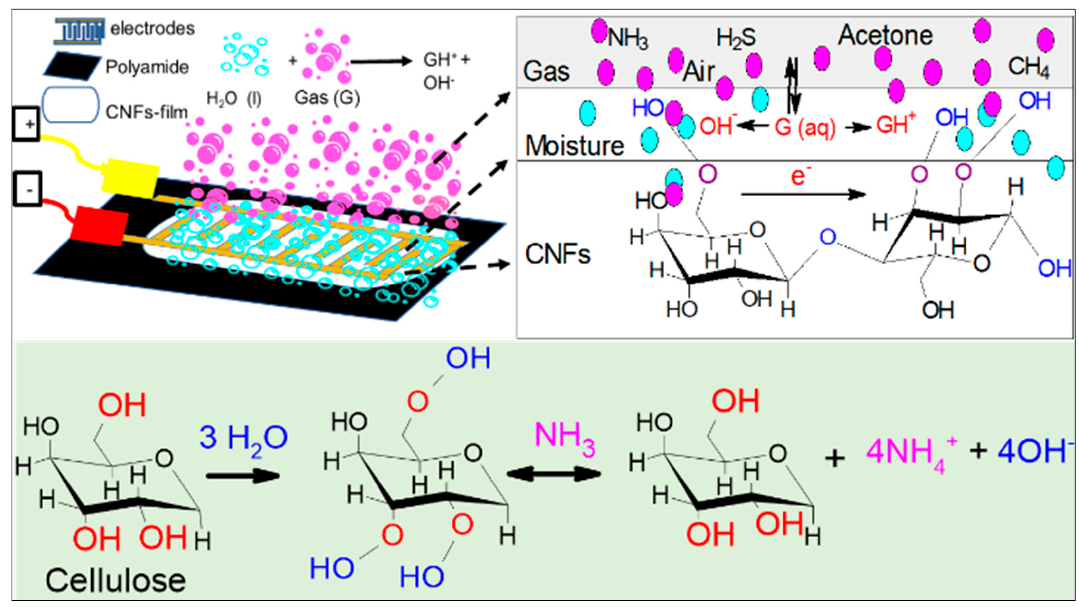
Figure 5. Schematic representation of possible water-soluble gas sensing mechanism in CNF-film